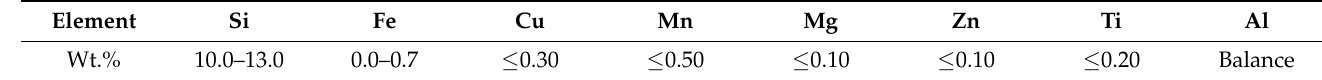
Table 2. Chemical composition of DM305 electronic glass (in wt.%).